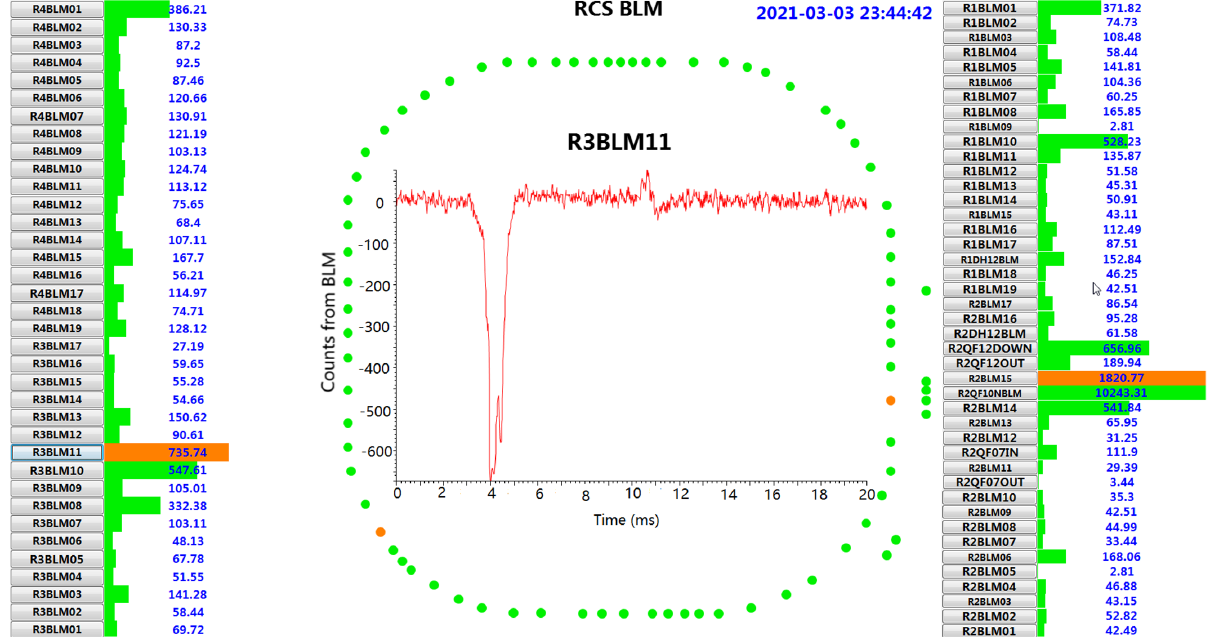
FIG. 5. Beam loss distribution across the whole RCS measured by beam loss monitors (BLM) in the target-shooting mode. The green color indicates that the beam loss is totally negligible, and the orange color gives a warning of beam loss level but still below the threshold to trigger the machine protection system.